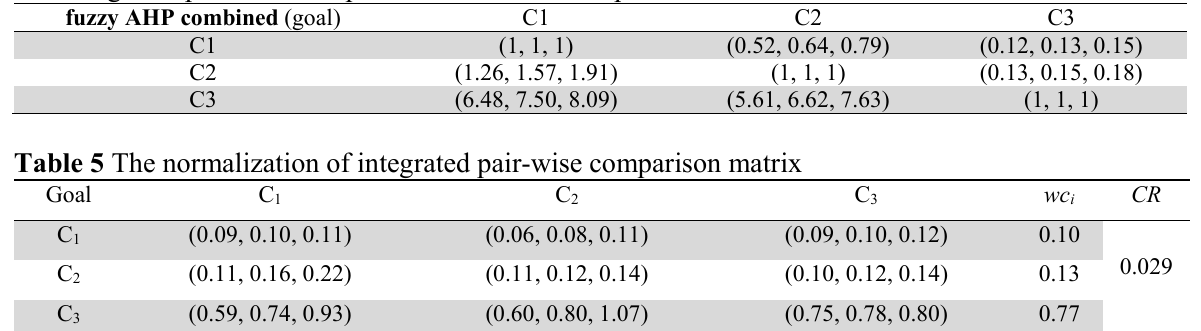
The integrated pair-wise comparison matrix of six experts.